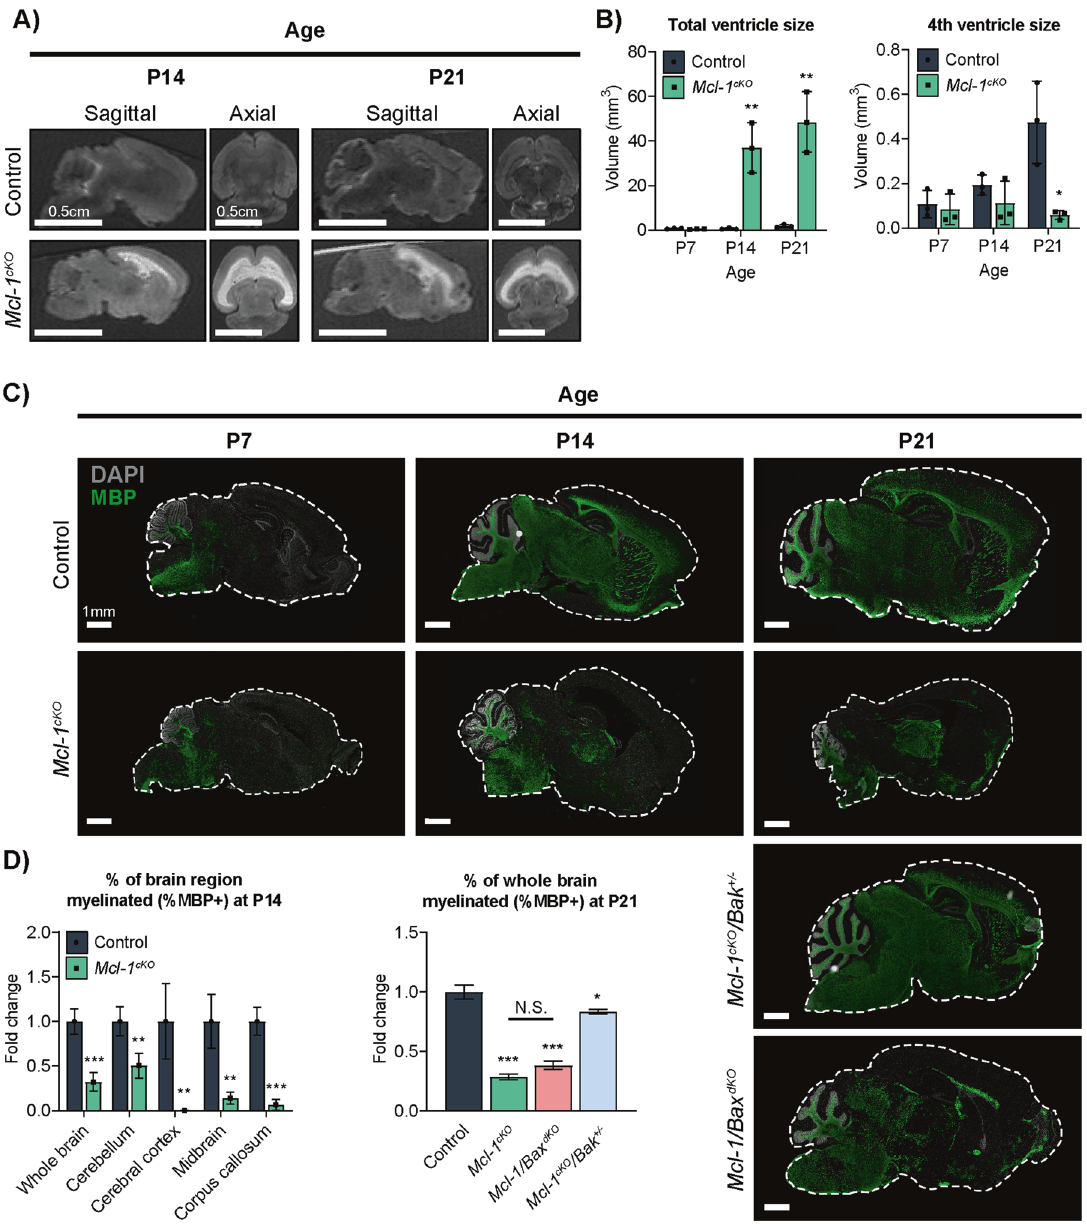
Fig. 4 Abnormal neuroimaging and myelination in Mcl-1 -deleted mice, with different rescue effects caused by co-deletion of Bak or Bax . A Representative MRIs show white matter hyperintensity in Mcl-1 cKO mice. B Total ventricular volume is abnormal in Mcl-1 cKO mice and increases from P7 to P21, while the volume of the fourth ventricle decreases signi fi cantly by P21. C , D Representative images and quantitative analysis of Myelin Basic Protein (MBP) IHC show that myelination is markedly decreased in Mcl-1 cKO mice, rescued in Mcl-1 cKO /Bak + / − mice, and incompletely rescued in Mcl-1/Bax dKO mice. D Graphs show MBP + area/total area within individual sections, normalized to the mean value in the control mice. *, **, and *** denote p < 0.05, p < 0.01, and p < 0.001, respectively, relative to